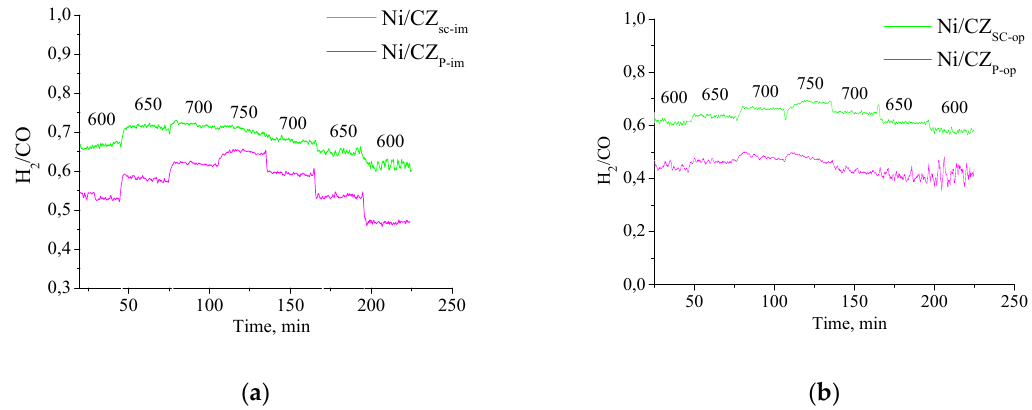
Figure 14. The dependence of H 2 /CO ratio on reaction time for impregnated ( a ) and one-pot ( b ) 5% Ni/Ce 0.75 Zr 0.25 O 2 catalysts prepared using the Pechini route and via supercritical synthesis.